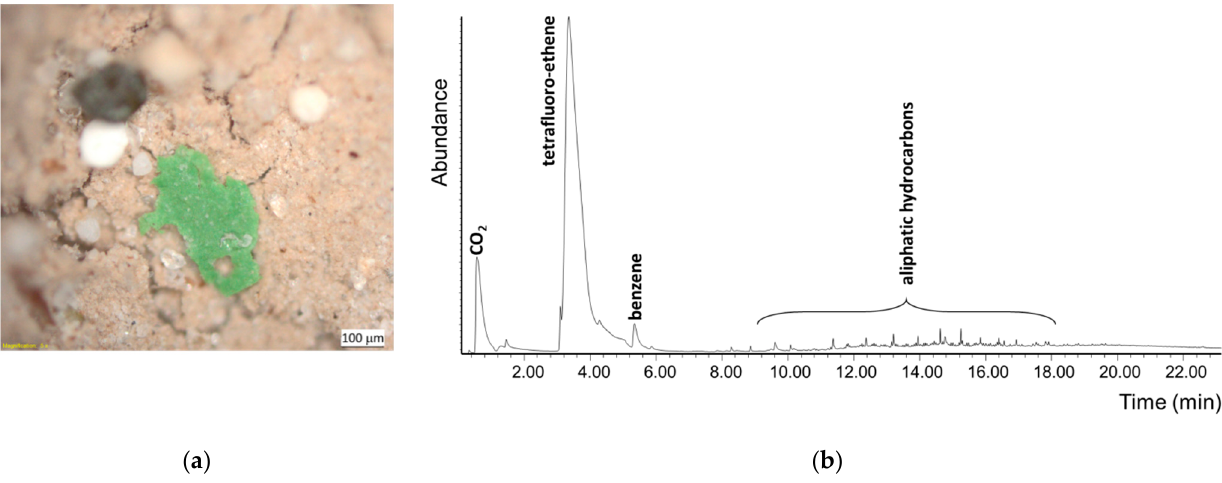
Figure 9. PTFE microparticles found in the inorganic sediment residue after all extraction and hydrolysis procedures performed on the MEL1 sample: ( a ) micrograph of a green microparticle taken with a stereomicroscope; ( b ) pyrogram of the microparticle.